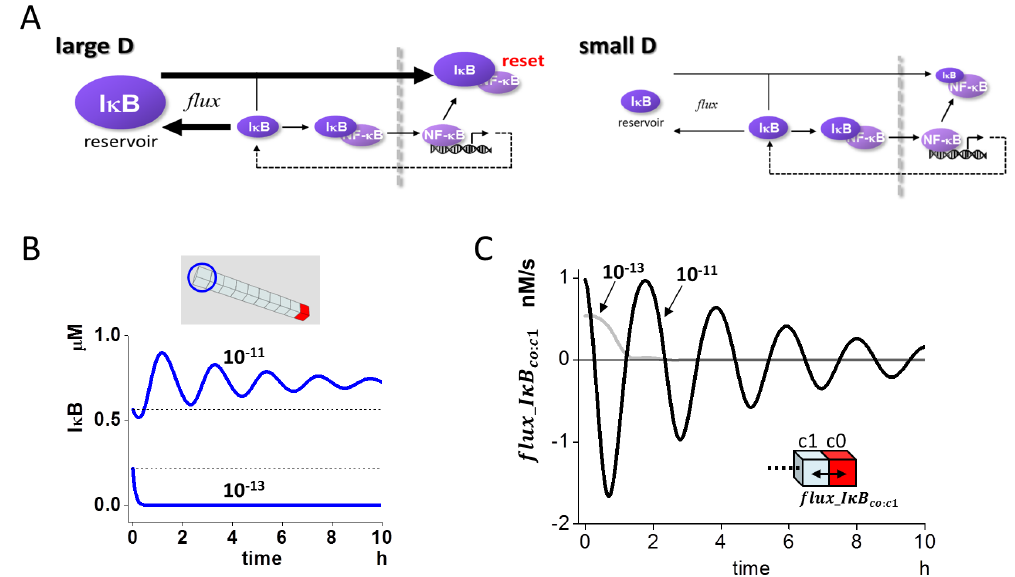
Figure 4. Storing I k B at a distant location in cytoplasm is critical for the oscillation. (A) A hypothesis why difference in the diffusion coefficient results in the difference in the ‘‘reset’’ state of NF- k B n . At large D, newly synthesized I k B was transported to a distant location in the cytoplasm with the large flux due to a large D, and the distant location acts as a ‘‘reservoir’’ for I k B. I k B in the ‘‘reservoir’’ diffused back to the nucleus in the subsequent time period, and was used to ‘‘reset’’ NF- k B n . In contrast at small D, the flux transporting I k B was small, and only a small amount of I k B was stored in the ‘‘reservoir’’. This resulted in the imperfect ‘‘reset’’ of NF- k B n reaching towards the equilibrium. (B) When D was large (10 2 11 m 2 / s), a considerable amount of I k B was stored at the distant compartment indicated by a blue circle (top panel). The peak concentration was significantly higher than the resting level (upper broken horizontal line in the bottom panel). In contrast, it was much lower at the distant compartment, when D was small (10 2 13 m 2 /s). These simulation results strongly support the hypothesis shown in (A). (C) Diffusion fluxes of I k B between c0 and c1 are shown. Fluxes relative to 10 5 s after the start of the oscillation were measured to show net inward (negative value) and outward (positive value) flux to and from c0. At D of 10 2 11 m 2 /s, large inward fluxes were seen periodically indicating net inward flow from c1 to c0 (black line). On the contrary, only outward flux from c0 was seen at D of 10 2 13 m 2 /s indicating no replenishment to c0 from c1 in this small D condition (gray